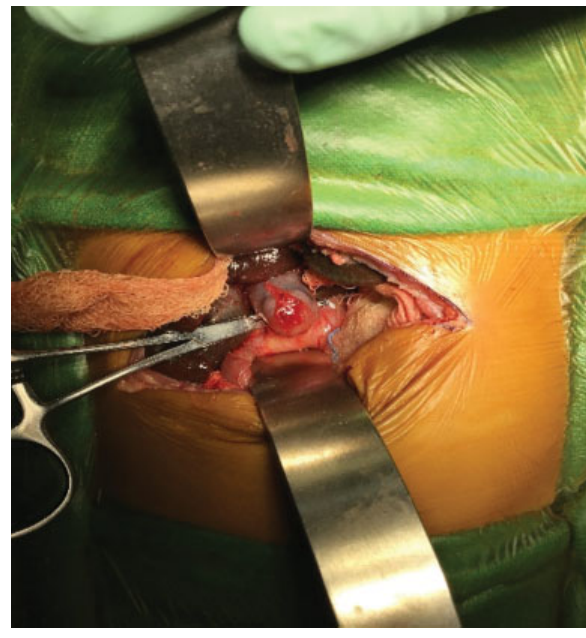
Fig. 5 Intraoperative image showing blind ending dilated common hepatic duct (cyst) noncommunicating with cystic